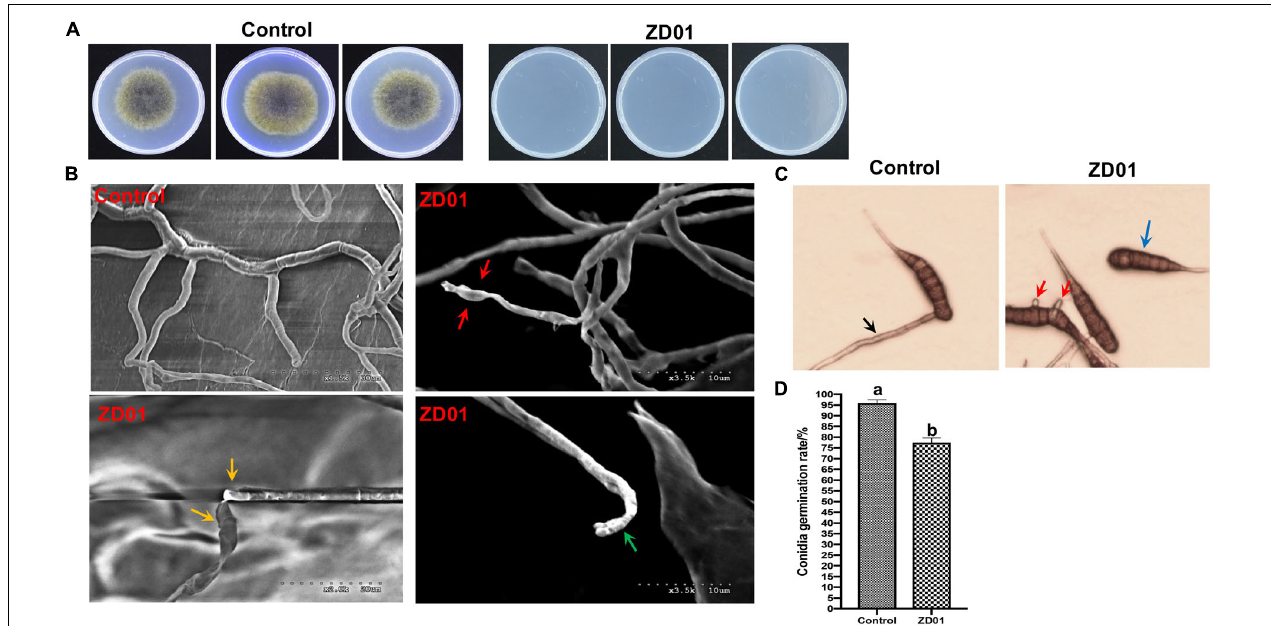
FIGURE 2 | Effects of strain ZD01 volatiles on mycelia penetration and morphology as well as conidia germination of A. solani . (A) Mycelia penetration inhibition by ZD01 volatiles. (B) Scanning electron micrographs of A. solani co-cultured with ZD01 volatiles. (C,D) Reduction of conidia germination of A. solani with the treatment of ZD01 volatiles. Control represents A. solani without treatment of ZD01 VOCs; ZD01 represents A. solani with treatment of ZD01 VOCs. Data presented are the mean ± s.d. ( n = 3). The same letter on the bars for each column indicates no significant difference according to a LSD test at P =